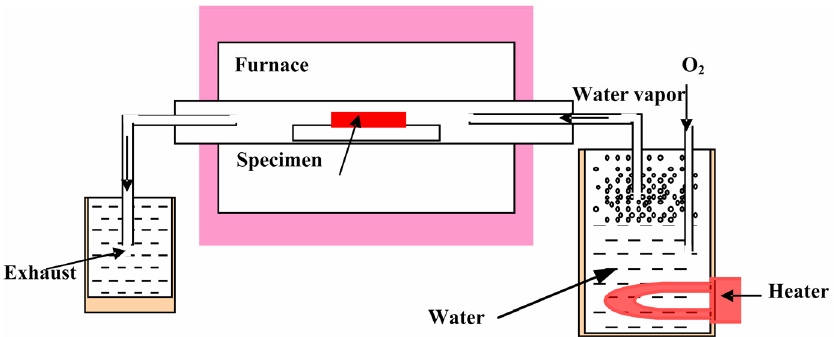
Fig. 1 Schematic diagram of experimental equipment for water vapor corrosion.